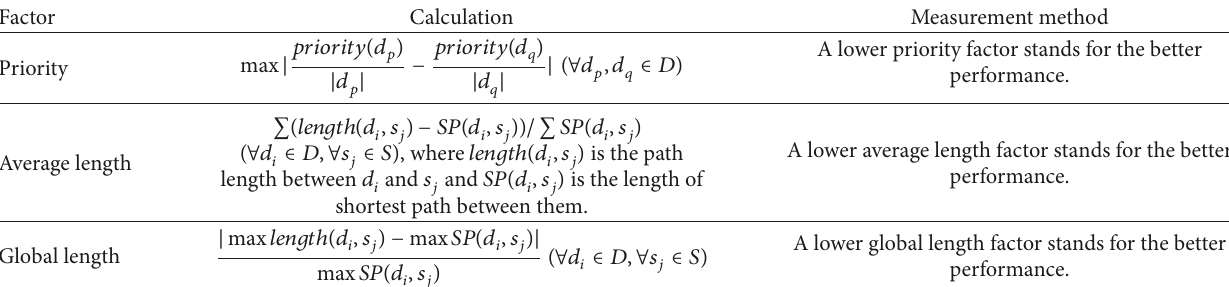
Table 1: Measurement index of algorithm